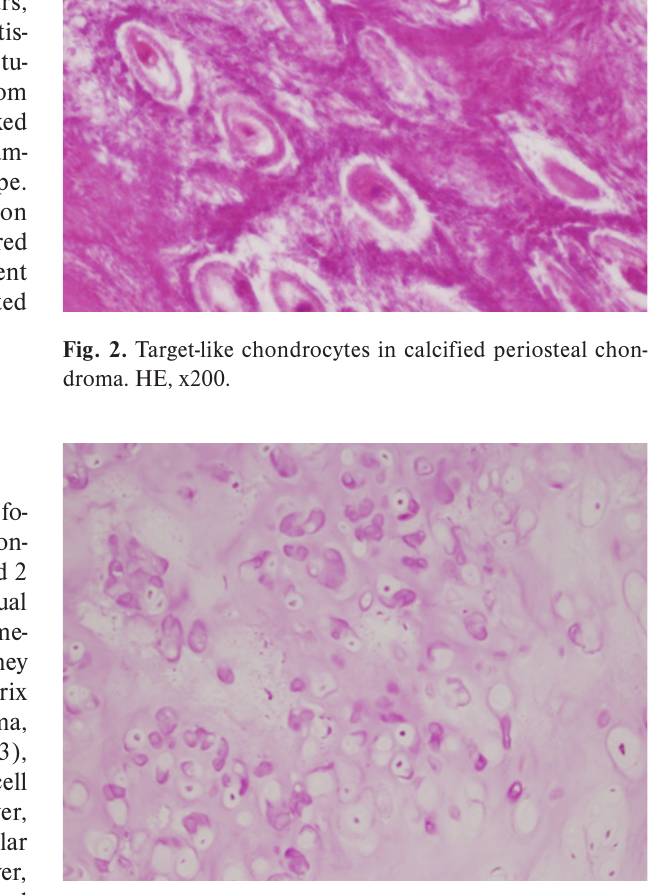
Fig. 3. Skeletal conventional chondrosarcoma contained one neoplastic lobule predominantly composed of malignant chon- drocytes with APAS positive thick rings,